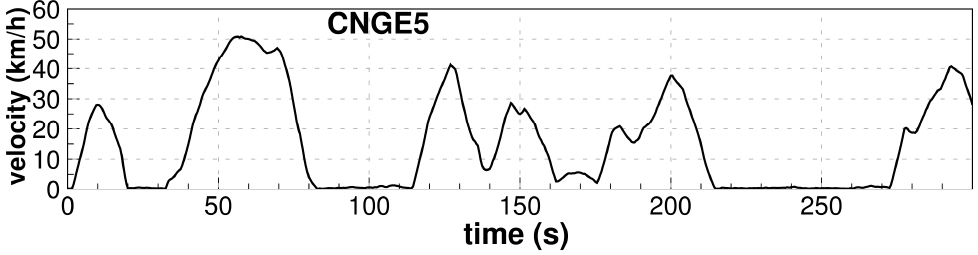
Figure 4. Typical time segment of the velocity time trace recorded with CNGE5 bus.